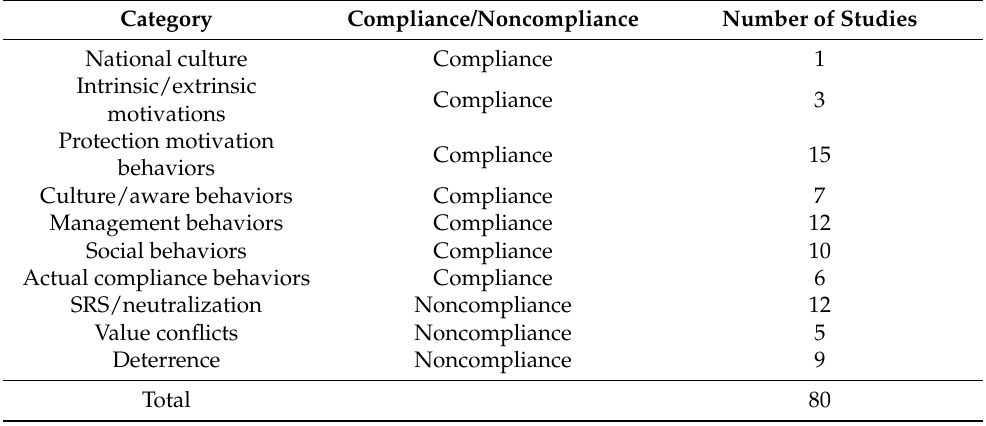
Table A5. Category wise study list.